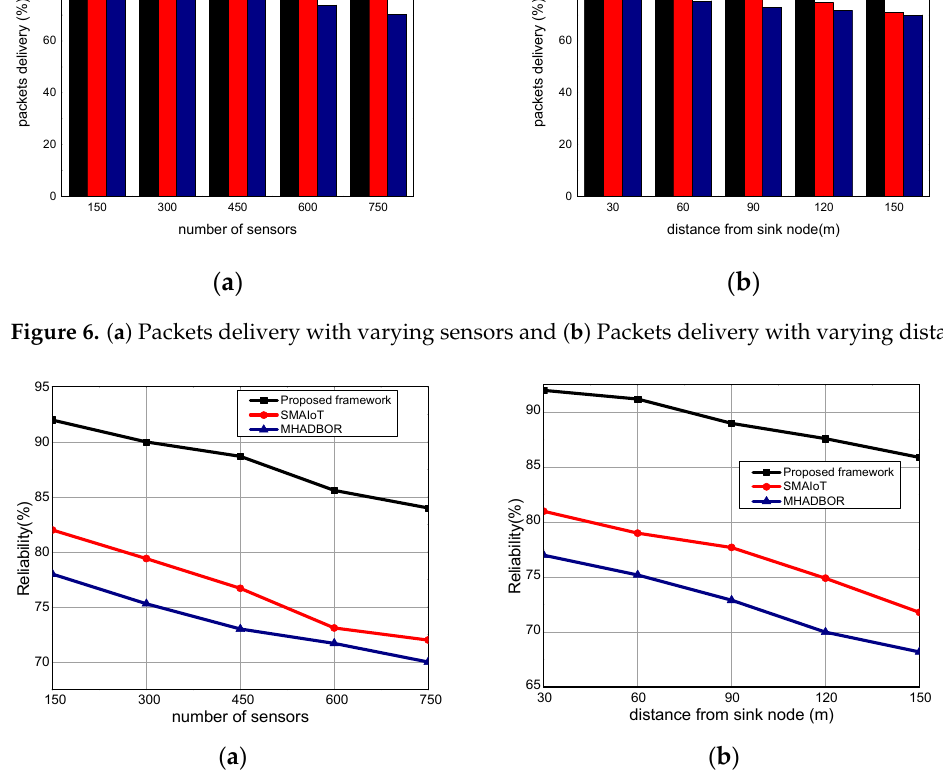
Figure 7. ( a ) Reliability with varying sensors and ( b ) Reliability with varying distance.